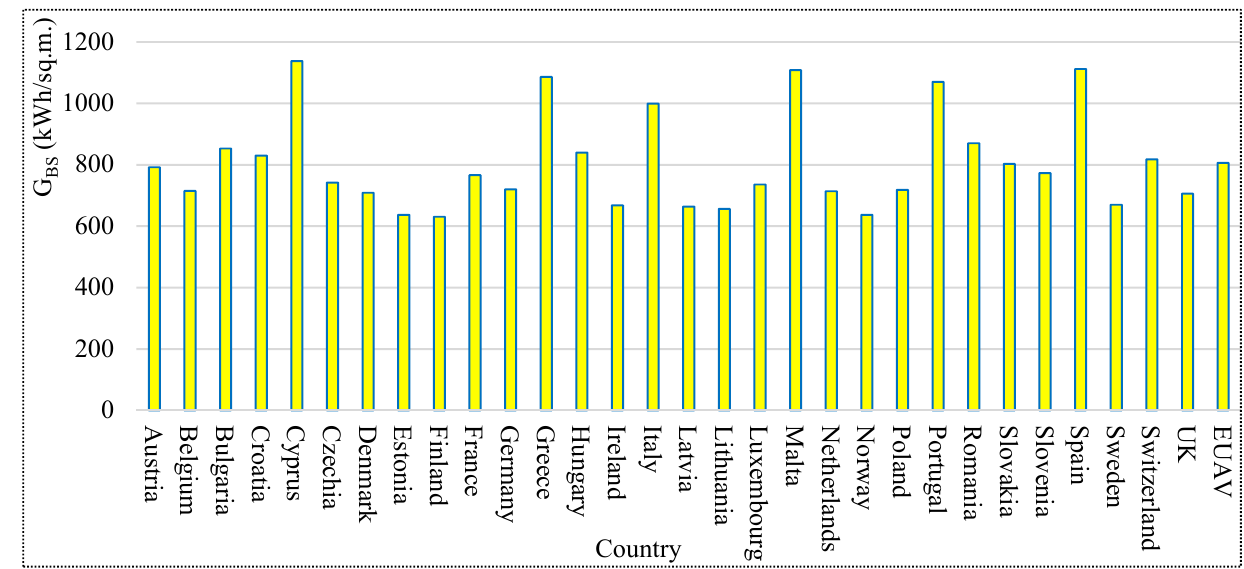
Figure 1. Average incident solar radiation on the building skins (G BS ) of the capital of the investigated countries.